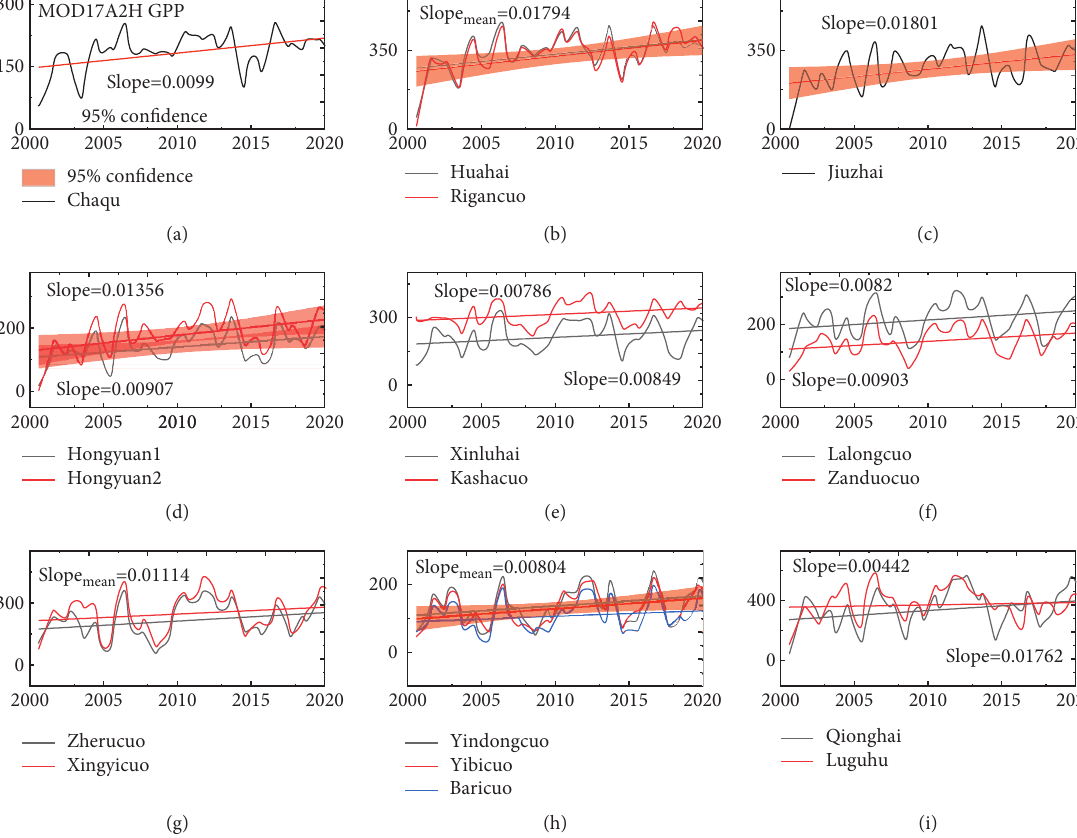
Figure 8: GPP change trend of the lake wetland on a site scale (2000–2020). The latitude of the lake site gradually decreased from subfigure (a) to (i). Elevation of sites (a), (d), (g), (f), and (h) are above 4500m, elevation of sites (b), (c), and (e) are about 3000–3900m, and elevation of site (i) is less than 3000m.